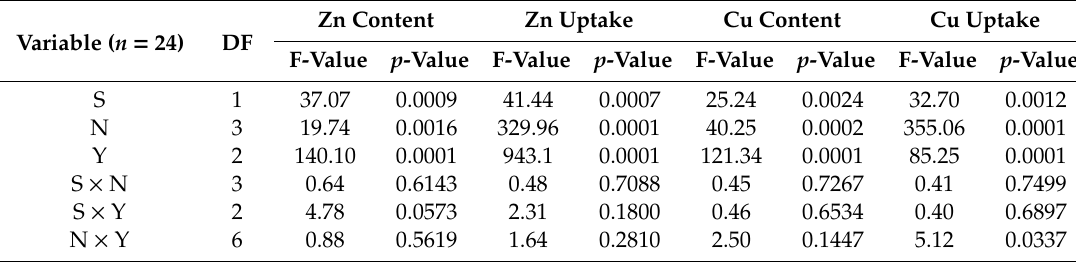
Table 5. Results of ANOVA statistical calculations for the studied features of spring rye content (mg kg − 1 ) and uptake (g ha − 1 ) of Zn and Cu by whole-grain DM. Zn Content Zn Variable ( n = 24) DF